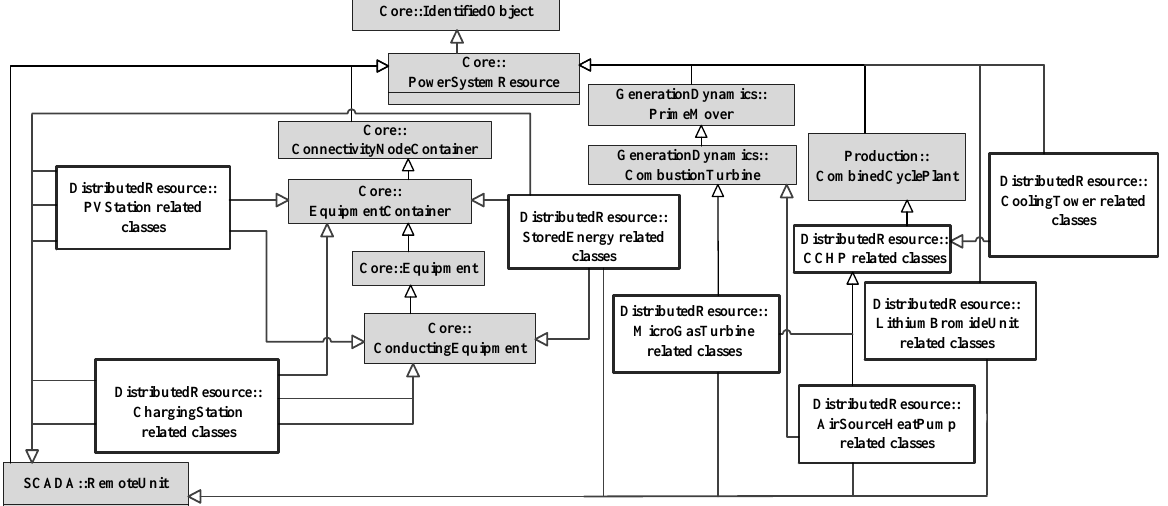
Figure 8. The simplified schematic class diagram for the distributed resource package.